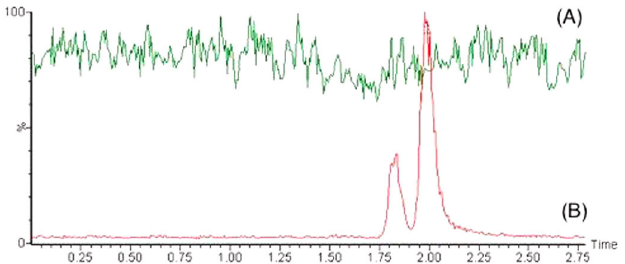
FIGURE 3 - Instrument response from constantly infused analytes after injecting an extracted blank sample into the UPLC-MS/MS system (A); UPLC-MS/MS injection of both analytes in mobile phase solution, not concomitant, just for comparison (B).